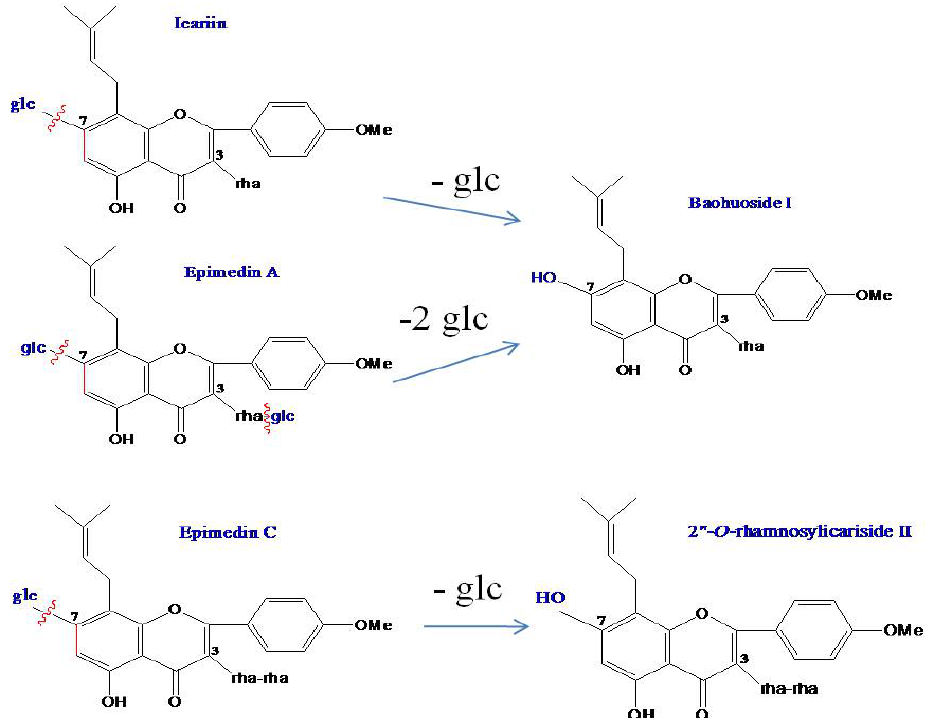
Figure 7. The possible metabolic pathways of icariin, epimedin A and epimedin C by